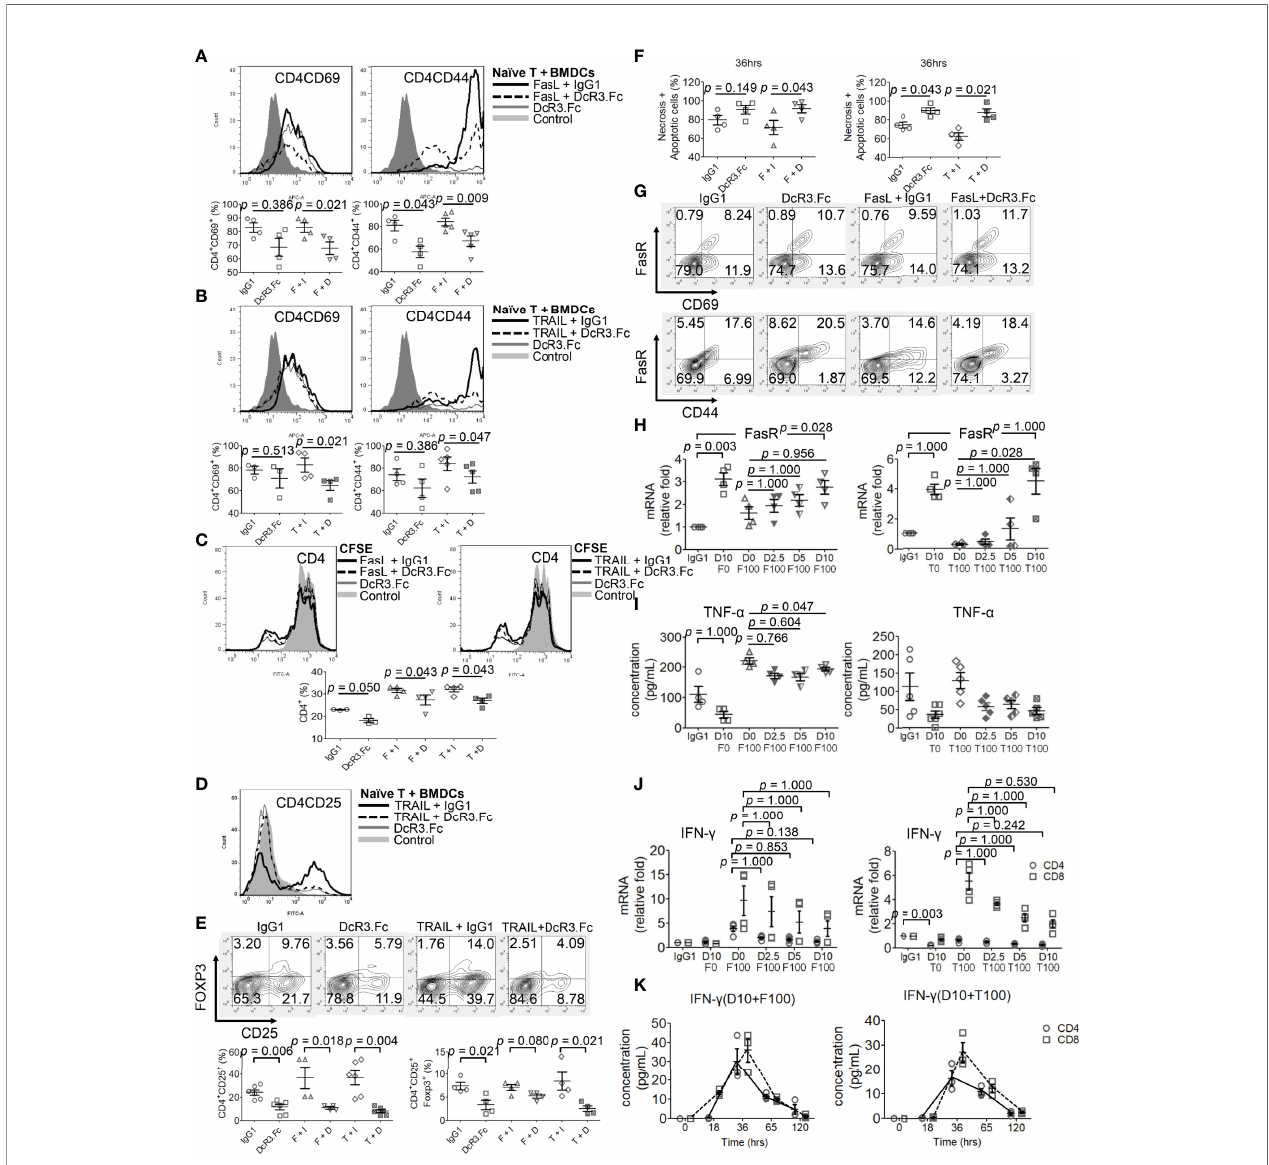
FIGURE 4 | Decoy receptor 3 (DcR3) suppresses FasL/TRAIL-related T-cell activation and proliferation, promotes effector T-cell (Teff) necrosis and apoptosis, and inhibits pro-in fl ammatory cytokines. (A, B) Teffs are obtained from naïve female T-cells from LN cells or spleen and are activated by male bone marrow-derived dendritic cells + lipopolysaccharide. IgG1, DcR3.Fc, FasL/TRAIL + IgG1, and FasL/TRAIL + DcR3.Fc-treated wild-type (WT) T-cells for 24 h were subcategorized into CD4CD69 and CD4CD44 and further presented by histogram and percentage of the indicated immune cells. The cells were double-stained with anti-mCD4- allophycocyanin (APC)-cyanine7(cy7)/CD44-APC or CD69-APC. Control means without treatment, not even IgG1 alone. (C) Carboxy fl uorescein diacetate, succinimidyl ester (CFSE) labeling assay. CFSE-labeled T-cells were treated with IgG1, DcR3.Fc, FasL/TRAIL + IgG1, or FasL/TRAIL + DcR3.Fc for 36 h before